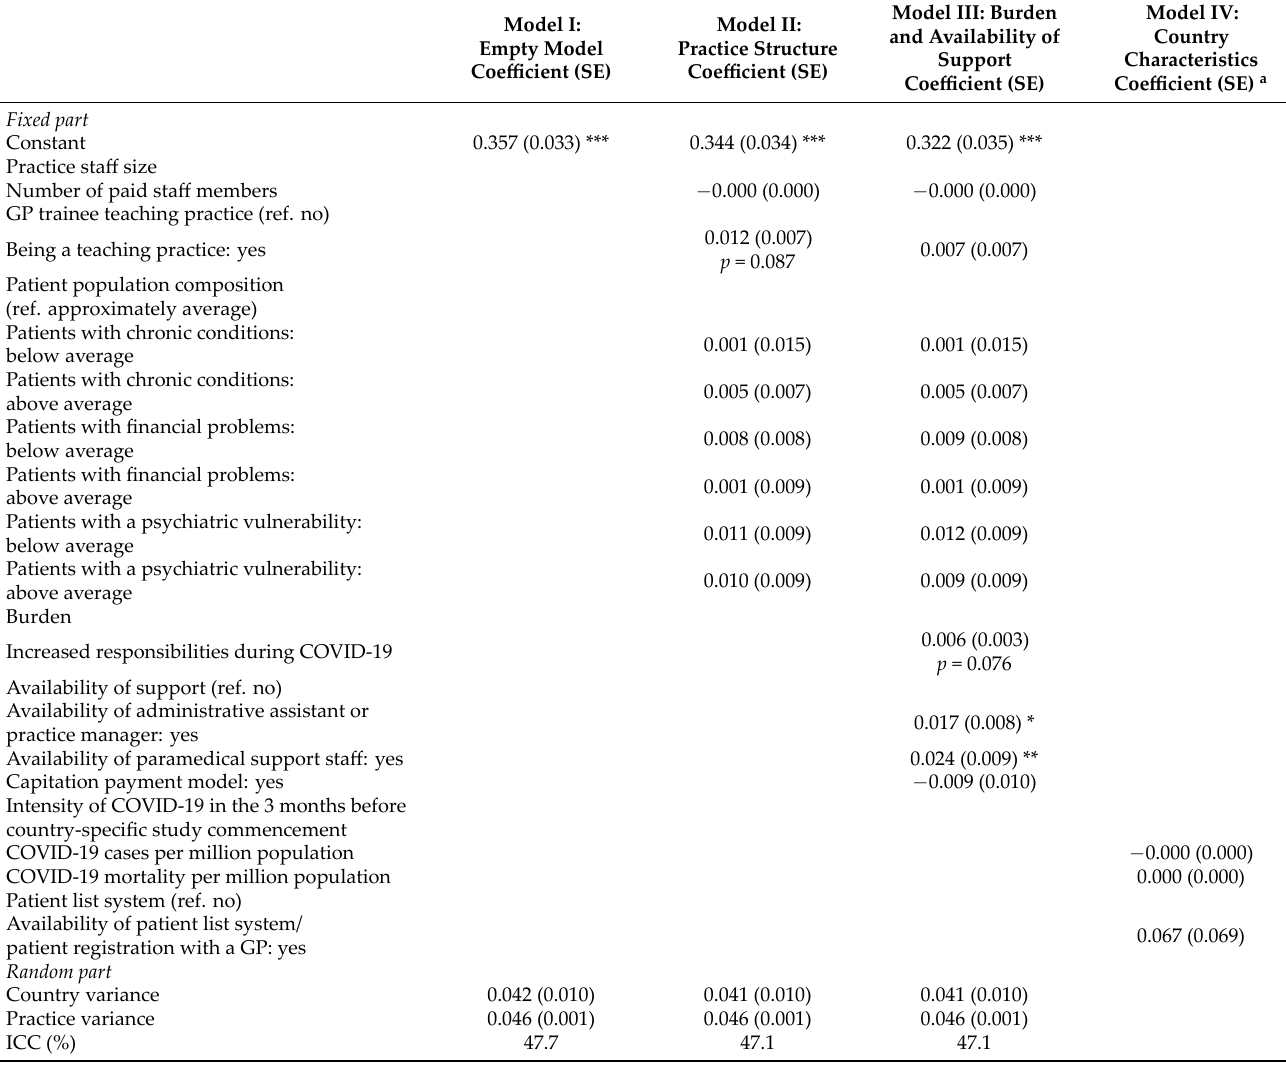
Table 4. The results of the linear mixed model analyses with outreach work as outcome